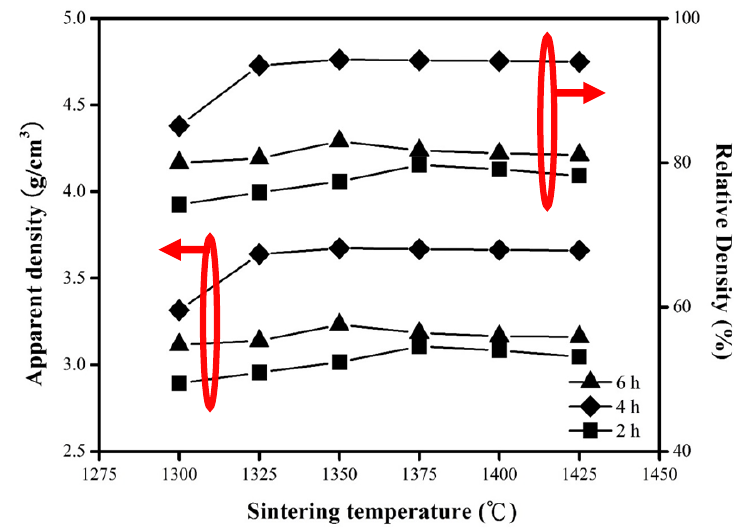
Figure 5. Dependence of apparent density and relative density on S.T. of the MNT ceramics for varied holding time. The left and right circles with arrows indicating apparent and relative density, respectively.